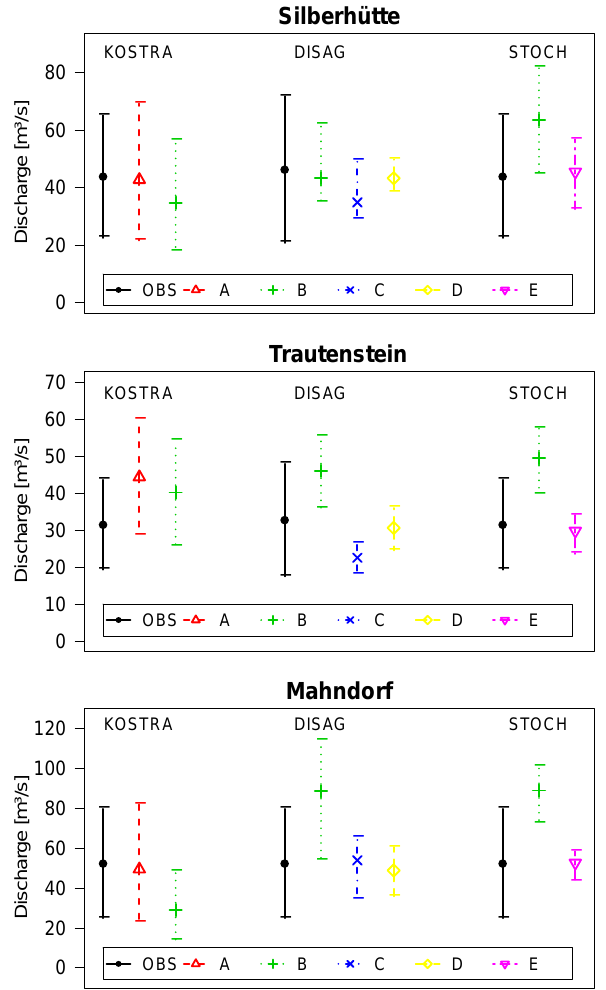
Fig. 12. Estimated 50yr floods with 90%-confidence bands for the three catchments and the five data sets (A–E) obtained from the dif- ferent calibration strategies using KOSTRA, DISAG and STOCH precipitation in comparison to flood estimation based on observed annual maximum flows